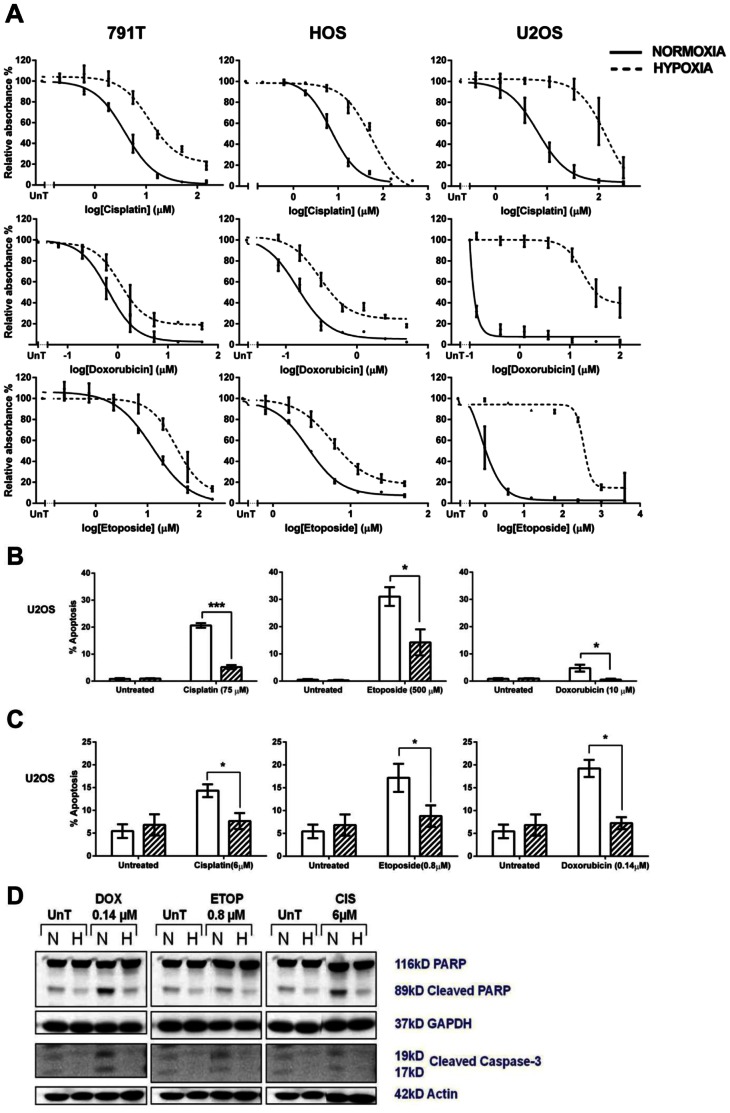
Hypoxia leads to cytotoxic drug resistance and reduces cytotoxic-induced apoptosis in osteosarcoma cells.A, Following a 24 hour pre-treatment incubation period in normoxia or hypoxia 791T, HOS and U2OS cells were treated with a range of concentrations of cisplatin (791T 0–150 µM; HOS 0–450 µM; U2OS 0–300 µM), etoposide (791T 0–180 µM; HOS 0–50 µM; U2OS 0–4000 µM) or doxorubicin (791T 0–48 µM; HOS 0–5 µM; U2OS 0–100 µM) for 1 hour. After a further 72 hours an SRB assay was performed. Graphs show the mean absorbance relative to the untreated controls (UnT) against log cisplatin, etoposide or doxorubicin concentration and are the mean ± SEM of 3 independent experiments. The difference between drug response in hypoxia and normoxia is highly significant p<0.001 in all cases (2-way ANOVA). B, 48 hours after exposure to a 1 hour pulse of doxorubicin (10 µM), etoposide (500 µM) or cisplatin (75 µM) in normoxia or hypoxia U2OS cells were stained with DAPI and morphologically apoptotic cells counted with a fluorescent microscope. Graphs represent the percentage of apoptotic cells in normoxia and hypoxia. Data are the mean ± SEM of 3 independent experiments. * indicates p<0.05 and *** indicates p<0.001 determined by the 2-tailed student t-test. C, 72 hours after exposure to a 1 hour pulse of doxorubicin (0.14 µM), etoposide (0.8 µM) or cisplatin (6 µM) in normoxia or hypoxia U2OS cells were stained with annexin V and 7-AAD and analysed by flow cytometry. Annexin V positive and/or 7-AAD positive cells were counted as apoptotic and graphs represent the percentage of apoptotic cells and are the mean ± SEM of 3 independent experiments.* indicates p<0.05 determined by the 2-tailed student t-test. D, Protein from this experiment was immunoblotted for PARP, cleaved PARP, caspase-3 and cleaved caspase-3 The amount of cleavage of PARP and caspase-3 was indicative of the amount of apoptosis occurring at that time point and was compared between normoxia and hypoxia.